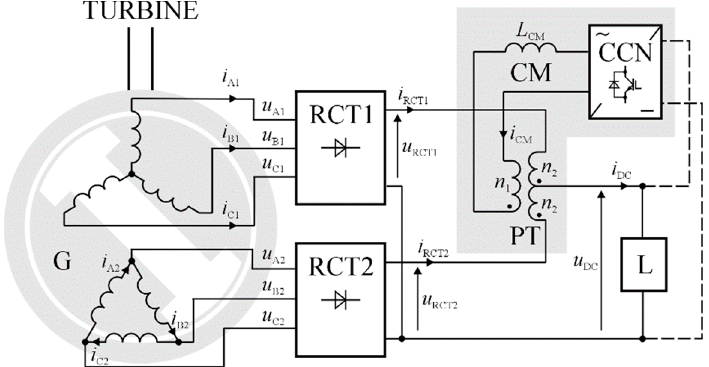
Figure 1. Block diagram of basic part of energy conversion system with permanent magnet synchronous generator with modulated magnetic flux (PMSG-MF). The power electronics converter block (CCN) is powered from DC rails (optional). PT, power pulse transformer; L, load; RCT1 and RCT2, diode rectifier.